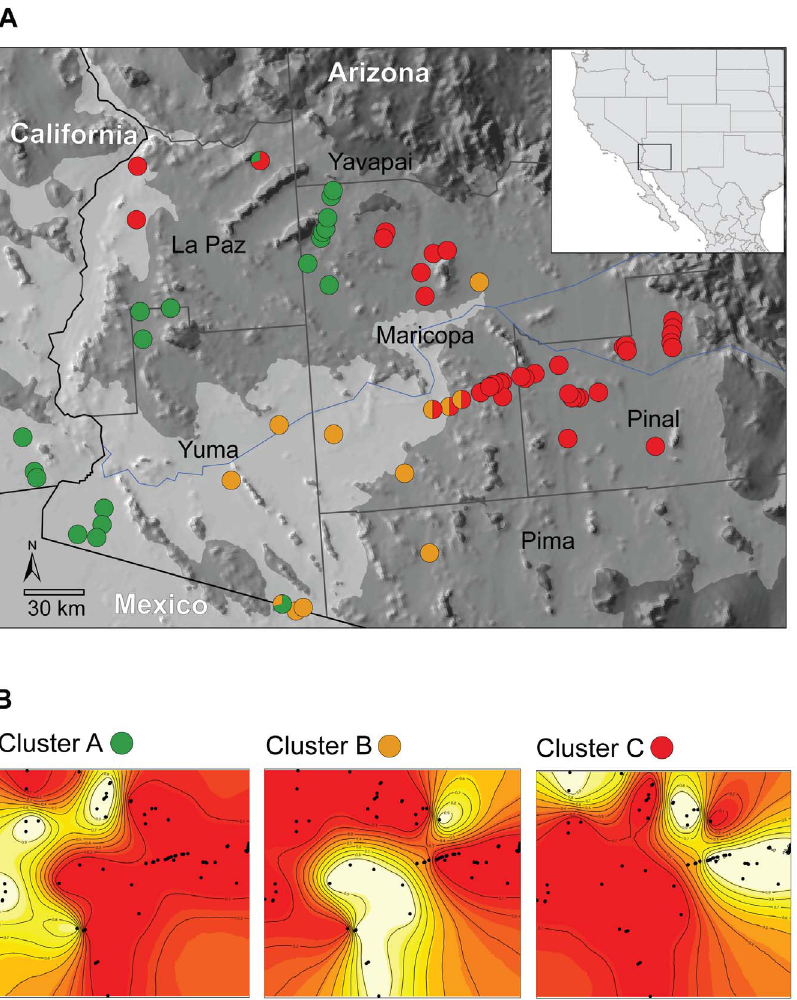
Figure 5. Spatially-explicit estimate of population structure across Arizona based on the GENELAND analysis. a ) Map of Arizona and the geographic distribution of sampled individuals colored according to the probability of assignment within each cluster identified using GENELAND (green, orange, and red circles represent individuals assigned to Clusters A, B, and C, respectively). The shading indicates elevations below 300m (light grey), between 300 and 1000m (grey) and above 1000m (dark grey). b ) Geneland probability contour maps for the three clusters across Arizona. The highest posterior probabilities are in white (p $ 0.9) and the lowest are in red (p # 0.1) – contour lines within each map depict the spatial change in population assignment probability.